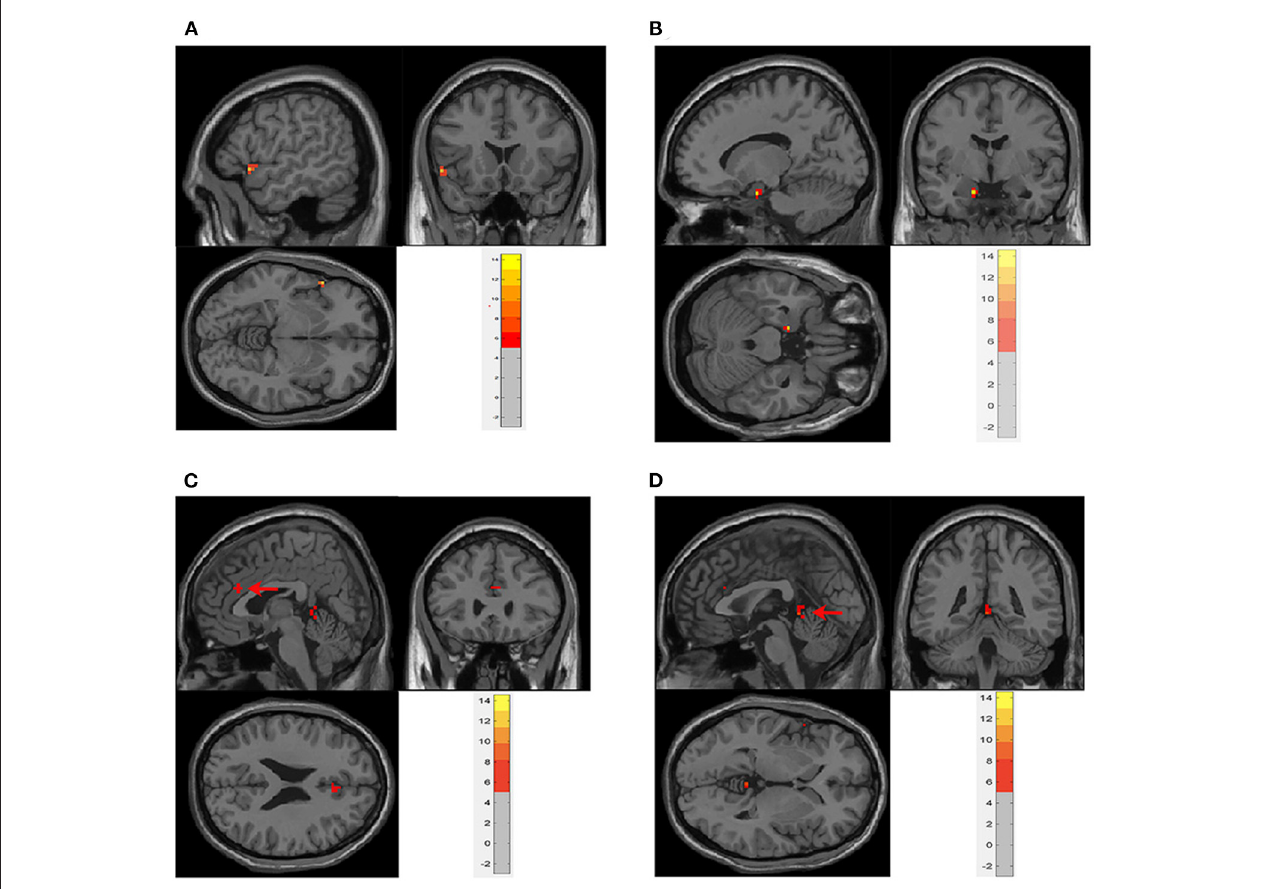
FIGURE 2 | Main effect analysis of neobladder volume sensation in all subjects. There was significant activation in (A) . Frontal lobe ( − 54, 18, and − 6); (B) parahippocampus ( − 15, − 3, and − 24); (C) anterior cingulate cortex (ACC) (3, 27, and 24); and (D) vermis (0, − 42, and 0) (cluster-level P ≤ 0.05, GRF correction). The first-level contrasts were defined by subtraction logic between INFUSION and WITHDRAW. GRF, Gaussian random